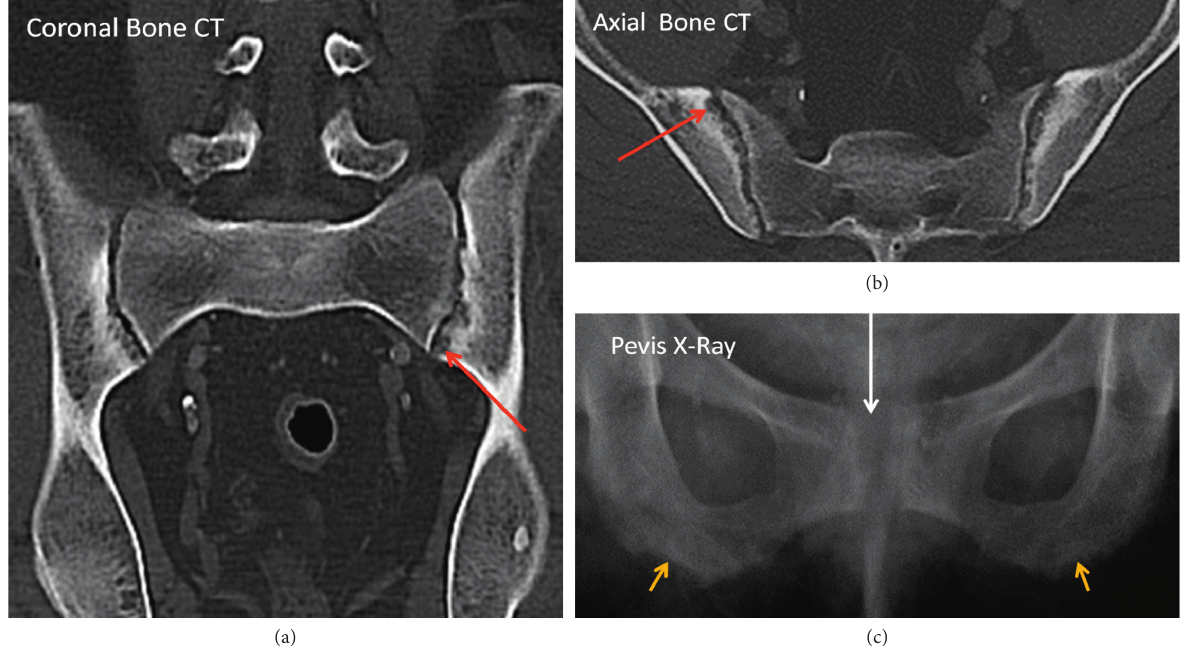
Figure 5: Subchondral resorption of the sacroiliac joints. Coronal and axial CT images show areas of subchondral lucency with irregular articular margin (red arrows), apparent widening of the joint space and surrounding hyperdense sclerosis. Pelvis X-ray symphysis pubis subchondral resorption (white arrow) with widening and also subligamentous resorption of the ischial tuberosities (yellow arrows). (a) Coronal bone CT. (b) Axial bone CT. (c) Pelvis